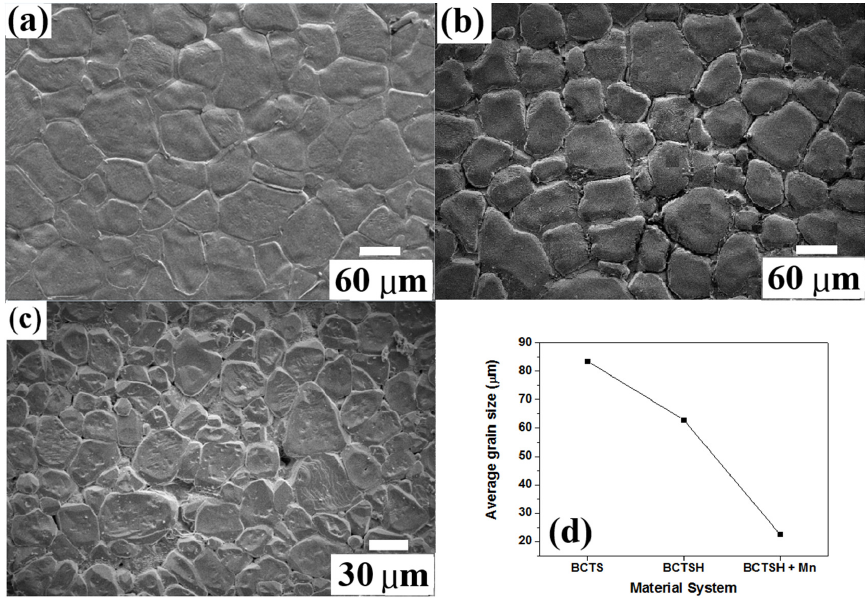
Figure 3. SEM images for ( a ) BCTS, ( b ) BCTSH, ( c ) Mn-doped BCTSH ceramics; ( d ) The average grain size of all proposed samples. grain size of all proposed